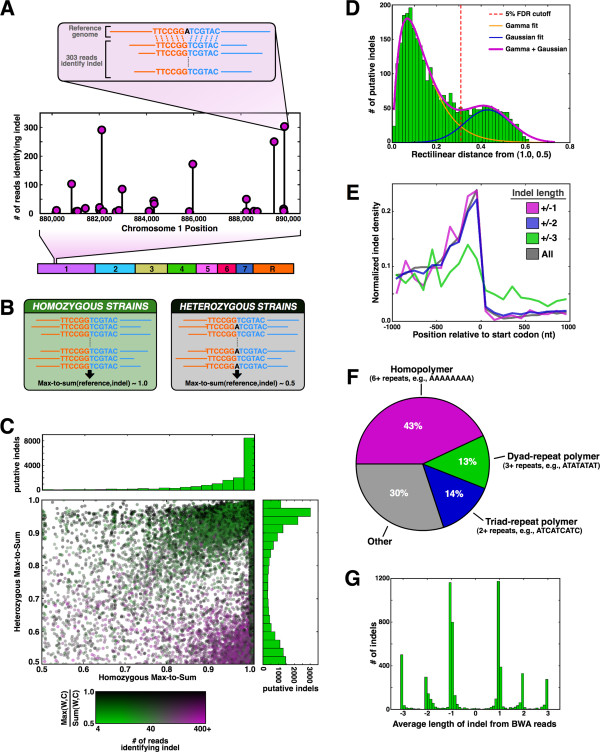
Indels are enriched in repeat sequences upstream of genes. (A) Close-up of 10 kb region of chromosome 1 containing several positions where hundreds of reads deviate from the reference in support of an indel. (B) Expected values for max-to-sum ratios of ‘reference’ and ‘indel’ reads in heterozygous and homozygous regions. (C) Scatterplot of max-to-sum ratios in heterozygous and homozygous regions for every putative indel in the genome. Histograms at top and right show the distribution of data on each perpendicular axis as indicated. The color of each point is based on the legend, where W and C indicate reads from the Watson and Crick strands, respectively. (D) The cutoff for indel designation, indicated in red, has a 5% false discovery rate (FDR), based on fitting the sum of gamma and Gaussian distributions, which reflect the true and false indels, respectively. The histogram in green considered only points with homozygous max-to-sum ratios <1.0 and rectilinear distances of 0.6 or less from the point [1.0,0.5]. (E) Indel density as a function of indel size and distance from the start codon. Density values were normalized to account for the fact that not all coding or intergenic regions span 1,000 nucleotides. (F) Indels are strongly enriched in repeat sequences. (G) Indels are not a sequencing artifact. The average size reported by all reads supporting an indel was calculated and then compiled into a histogram representing all indels. Random sequencing errors would have yielded density at non-integer values and, more importantly, around zero.